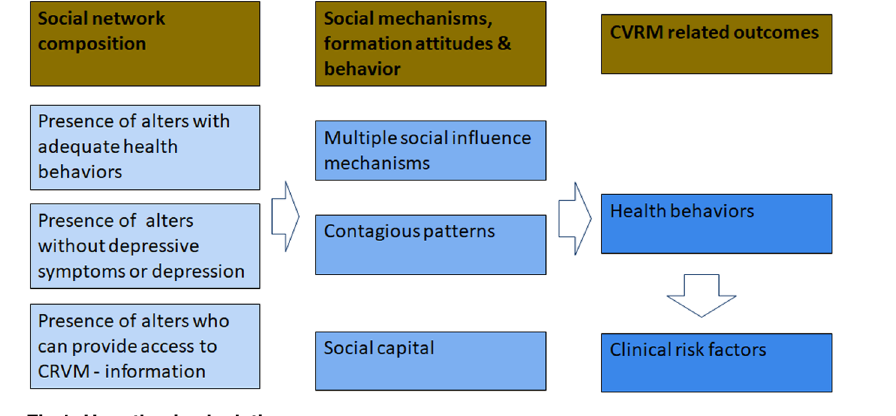
Fig 1. Hypothesized